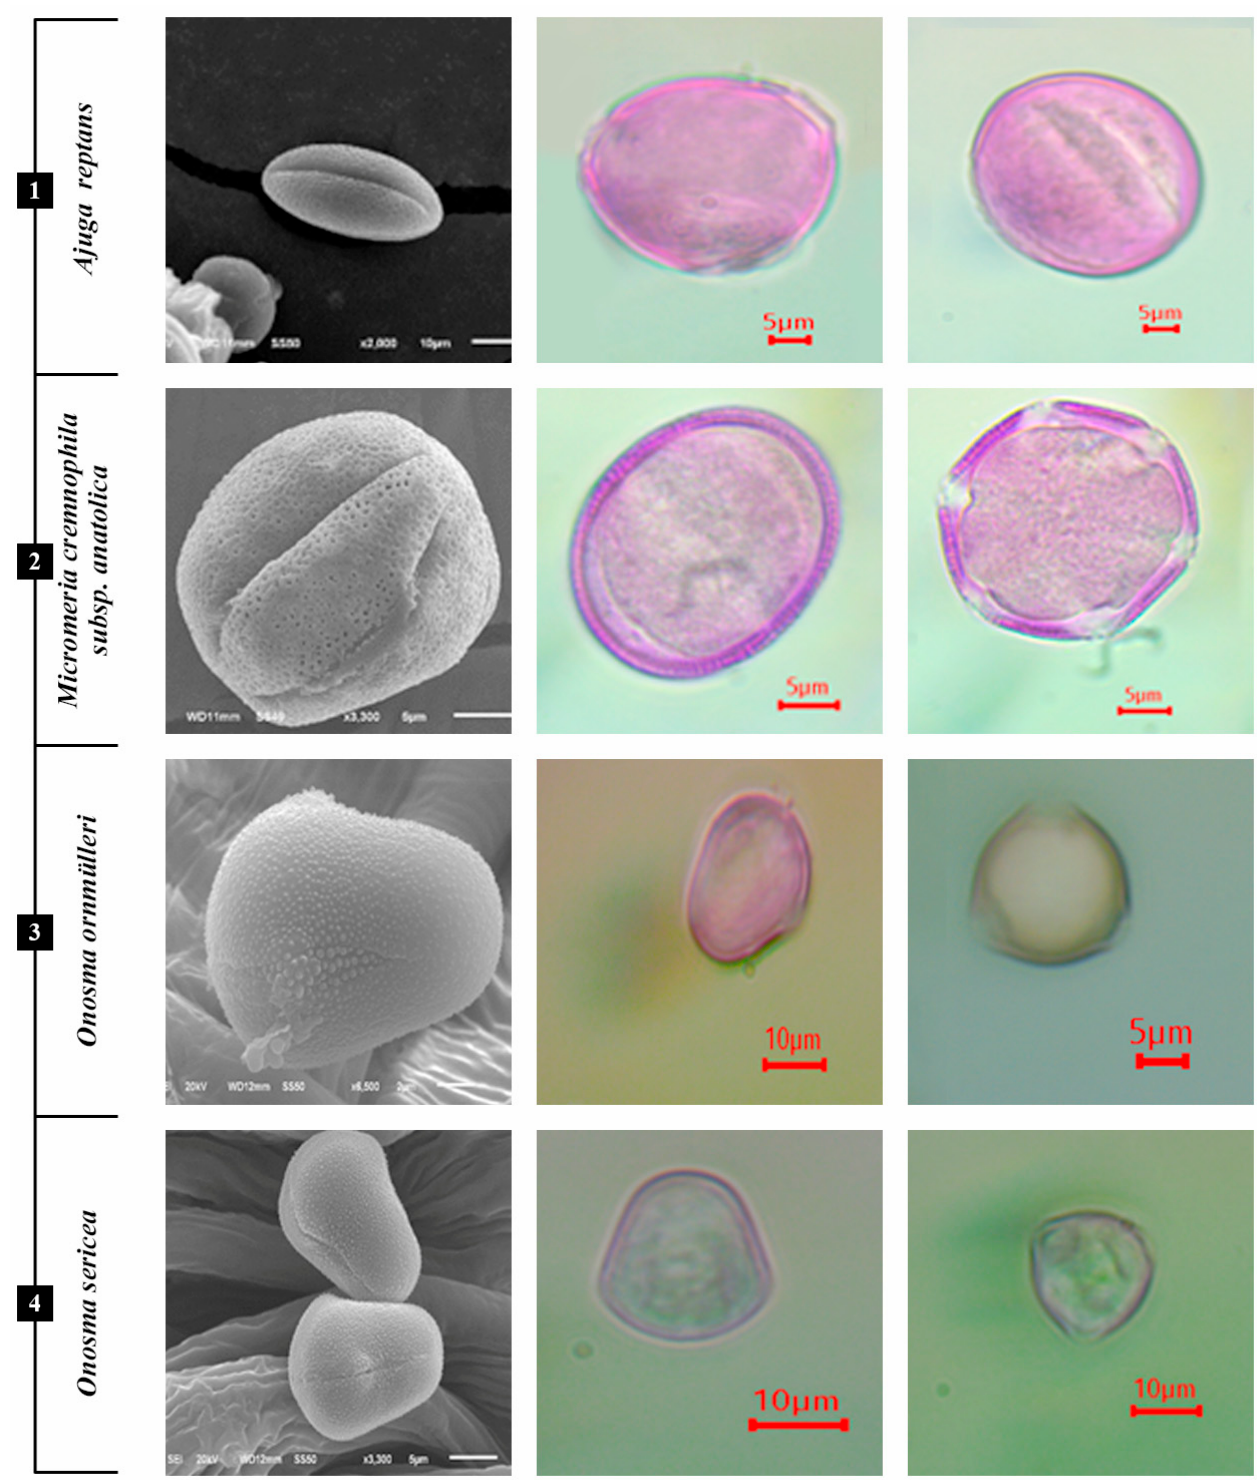
Figure 3. Scanning and light microscopic images of A. reptans , M. cremnophila subsp. anatolica , O. bornmülleri , and O. sericea .